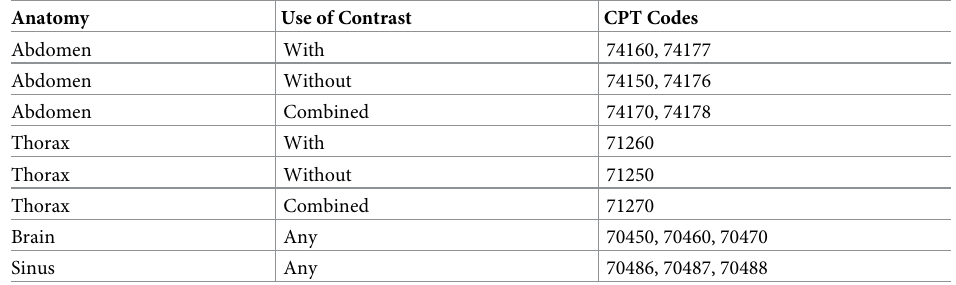
Table 1. Current Procedure Terminology (CPT) codes used to define groups in the